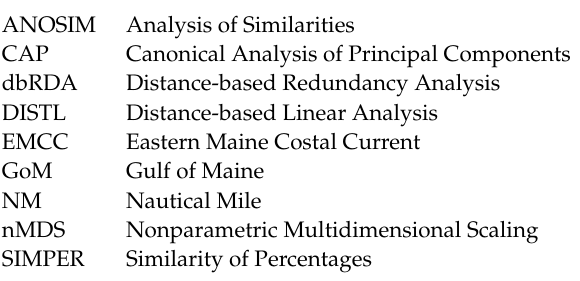
survey years. Table S1: Survey metadata for exposed rocky intertidal locations; Table S2: List of species present among surveyed GoM rocky intertidal exposed